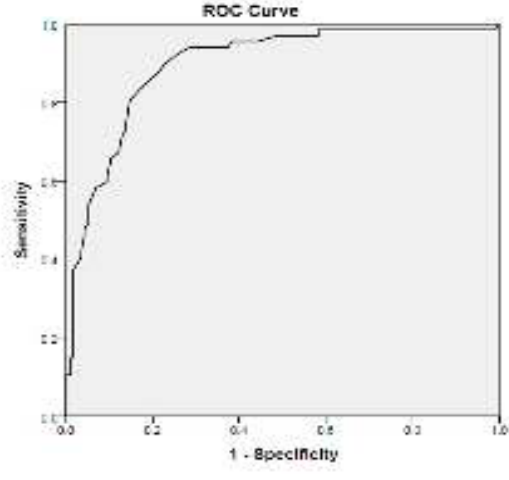
Figure1. Roc analysis of